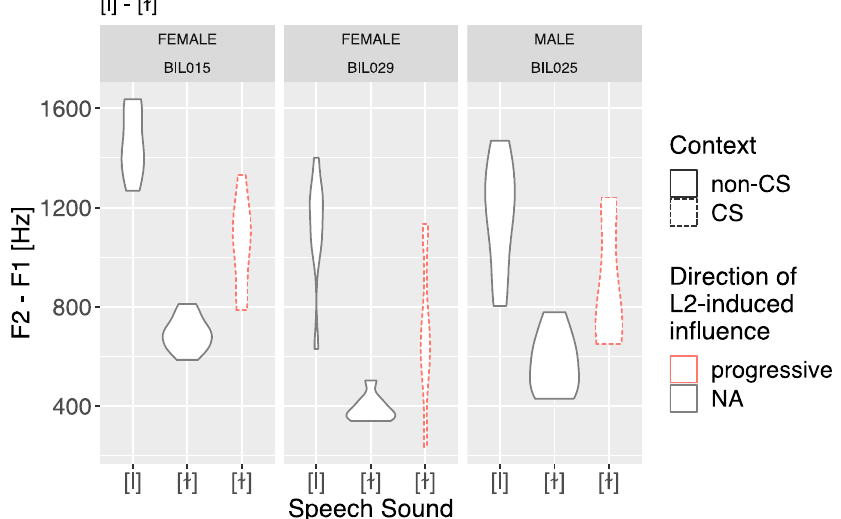
Figure 12. The distance between F1 and F2 of intended [l] and [ ɫ ] sounds in English words, spoken by 3 (2 female, 1 male) of the 25 BIL speakers, in non-CS (black), and of [ ɫ ] in CS (colored) environments (only progressive (red) L2-induced influences were available).